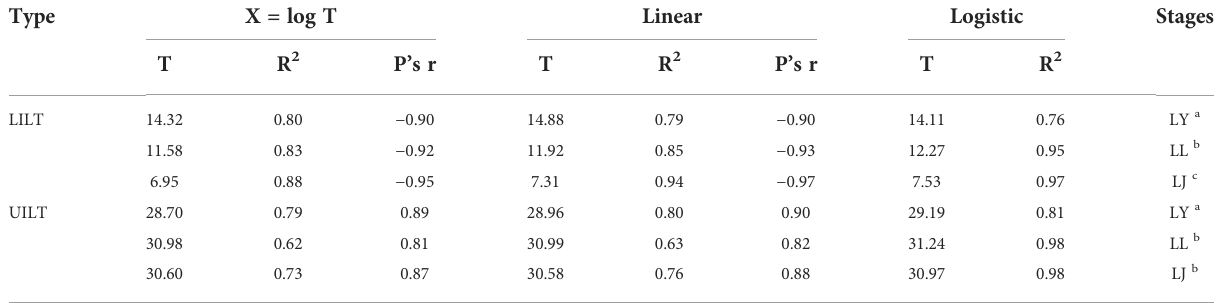
TABLE 3 Pearson ’ s r and R 2 for Larimichthys crocea yolk-sac larvae (LY), larvae (LL), and juveniles (LJ) about upper and lower incipient lethal temperature (LILT and UILT). Labeled means without a common letter differ ( P < 0.05). Type X = log T Linear Logistic